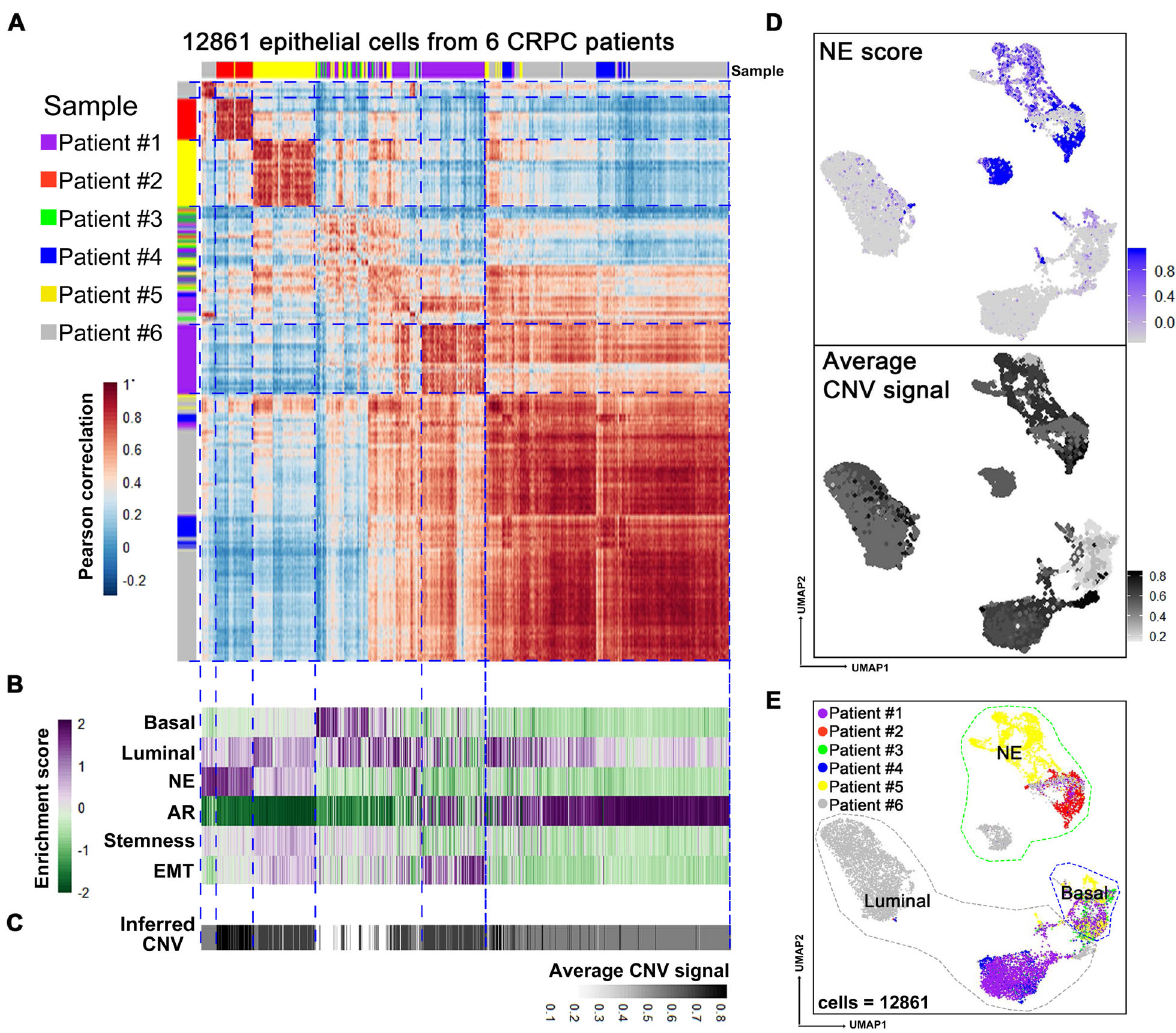
Fig. 2 NE cells present an epithelial phenotype. A Pairwise correlations between the expression pro fi les of 12,861 epithelial cells (rows, column) from 6 CRPC samples (color bar). Correlations were calculated across 63 lineage-speci fi c genes (Supplementary Table 2). B Enrichment scores for gene lists including basal, luminal, NE, AR, stemness, and EMT pathway associated genes. Cells were ordered as in ( A ). Green indicates a low score and purple indicates a high score. C Average inferred CNV signals of corresponding cells in ( A ). Black indicates the high CNV signal (Supplementary Fig. 3). D UMAP visualization of all 12,861 epithelial cells for the 6 patients with cells colored by the gradient of NE score (top) and average CNV signal (bottom). The minimum score is indicated by light gray and the maximum score is indicated by blue (top) or black (bottom). E UMAP visualization of all 12,861 epithelial cells from 6 patients with color-coded for the sample origin which kept concordant with ( A